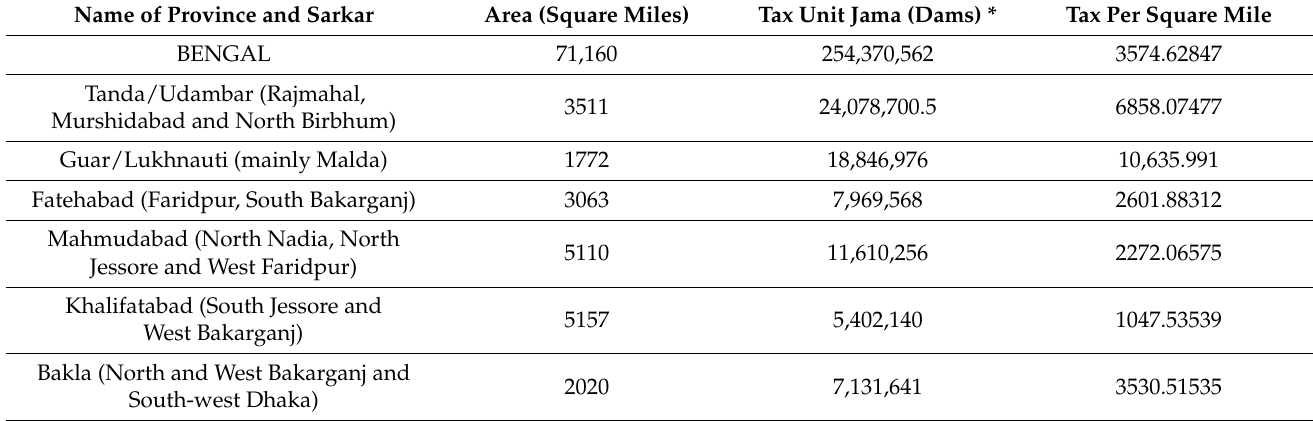
Table A1. Area and Jama (Revenue) of the Mughal Empire, c.1601. Source: This table is reused directly from Reference No. [36], (p.vii). https://en.banglapedia.org/index.php/Sarkar (accessed on 1 November